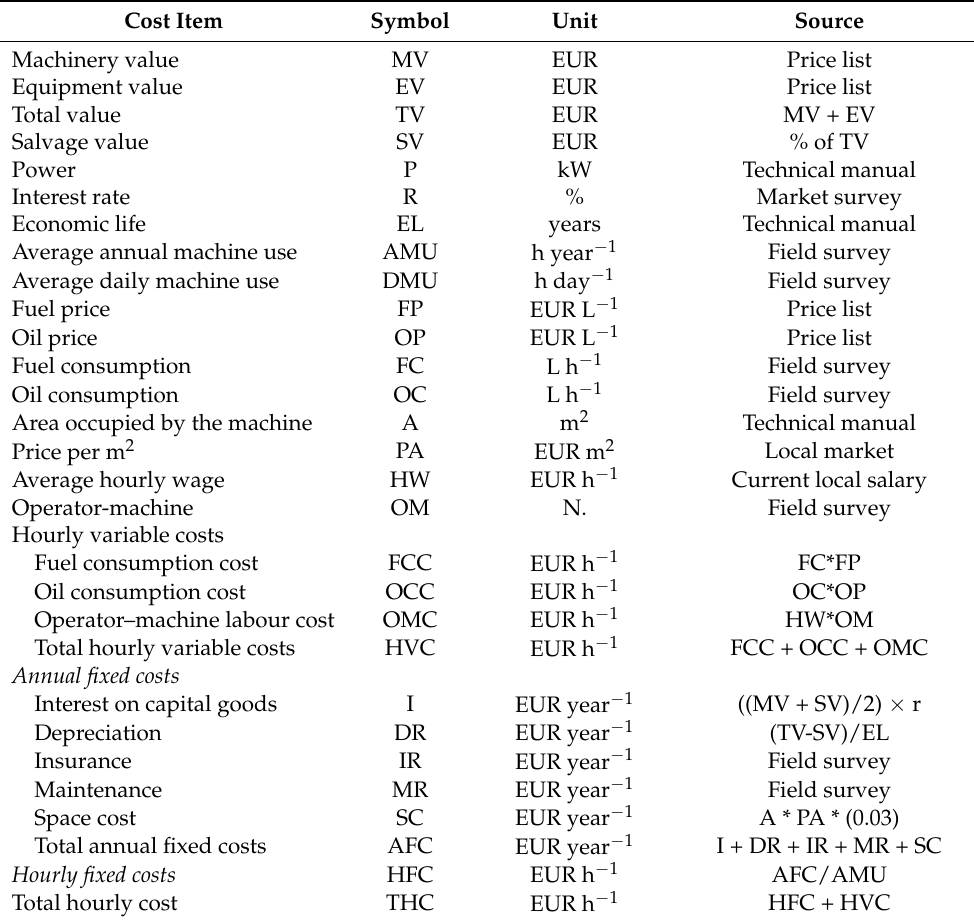
Table 2. Calculation of the machine hourly cost (Miyata 1980,